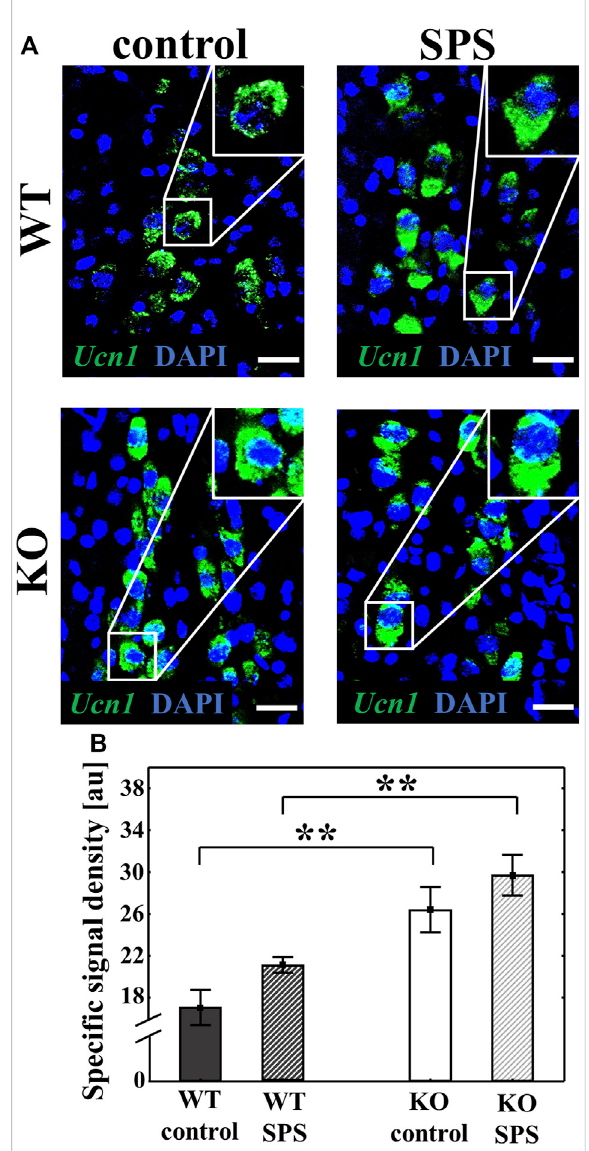
centrally projectingEdinger-Westphalnucleus (EWcp) uponsingle prolonged stress (SPS). Representative confocal images of the Ucn1 (green) mRNA expression in the EWcp neurons, visualized by RNAscope in situ hybridization. Sections were counterstained with 4 ′ ,6-diamidino-2-phenylindole (DAPI) (blue) for nuclei. Scale bars: 25 µm (A) . Columns represent the speci fi c signal density of Ucn1 mRNA/neuron (B) (two-way ANOVA followed by Tukey ’ s post-hoc test; ** p < 0.01; n = 8/group). au: arbitrary unit. WT: wild type, KO: